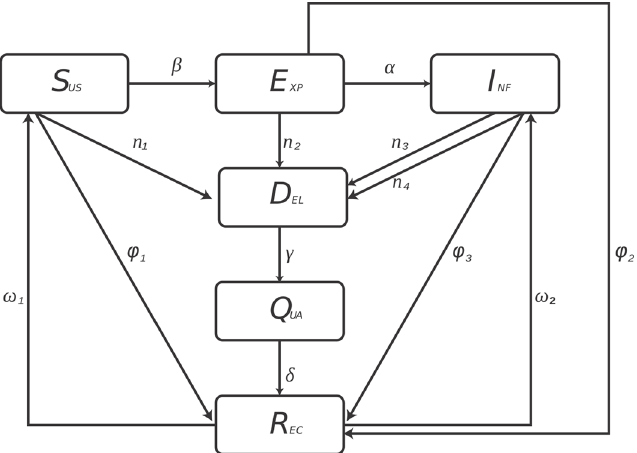
Fig 2. The states and the transitions of SEIDQR(S/I) model. The rectangles represent the compartments and the arrows represent the movement of hosts from one compartment to another. The labels on the rectangles indicate the type of compartment i.e. susceptible, exposed, infectious, delayed, quarantined and recovered. The labels on the arrows indicate the rate of transmission of hosts from one compartment to